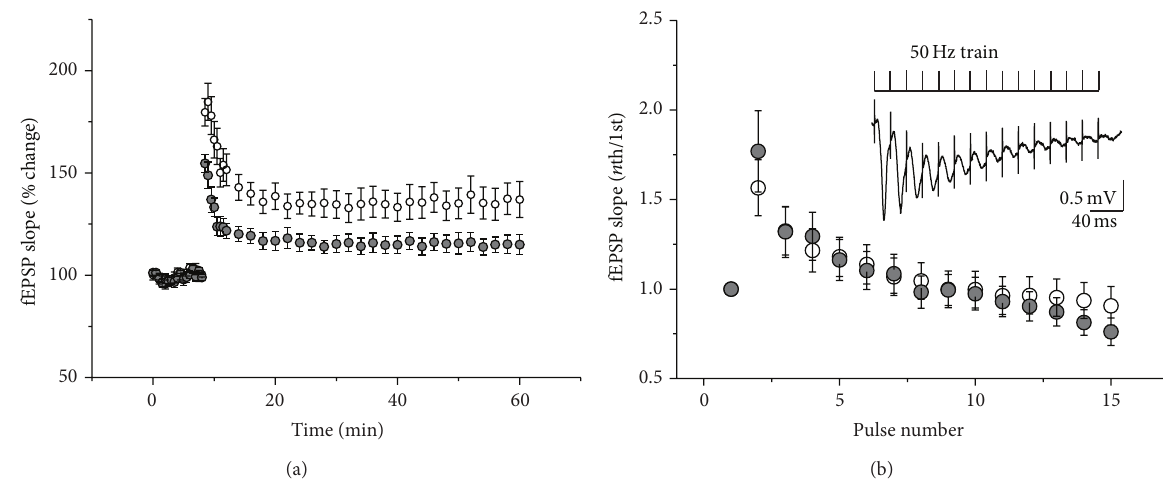
Figure 5: Effect of inhibition of NEU activity on the long-term potentiation and the short-term depression in hippocampal CA3-to-CA1 network induced by 50 Hz stimulus train. (a) Average of baseline-normalized initial slopes of fEPSP evoked by stimulation of Shaffer collateral before and after delivery of 50 Hz train in control (white) and NADNA-pretreated slices (grey). (b) Cumulative changes in field potentials recorded during 50 Hz stimulation in control (white) and NADNA-pretreated slices (grey). fEPSP slopes were normalized to the fEPSP slope in response to the first pulse and graphed versus pulse number. Inset: field potential recording during 50Hz HFS.